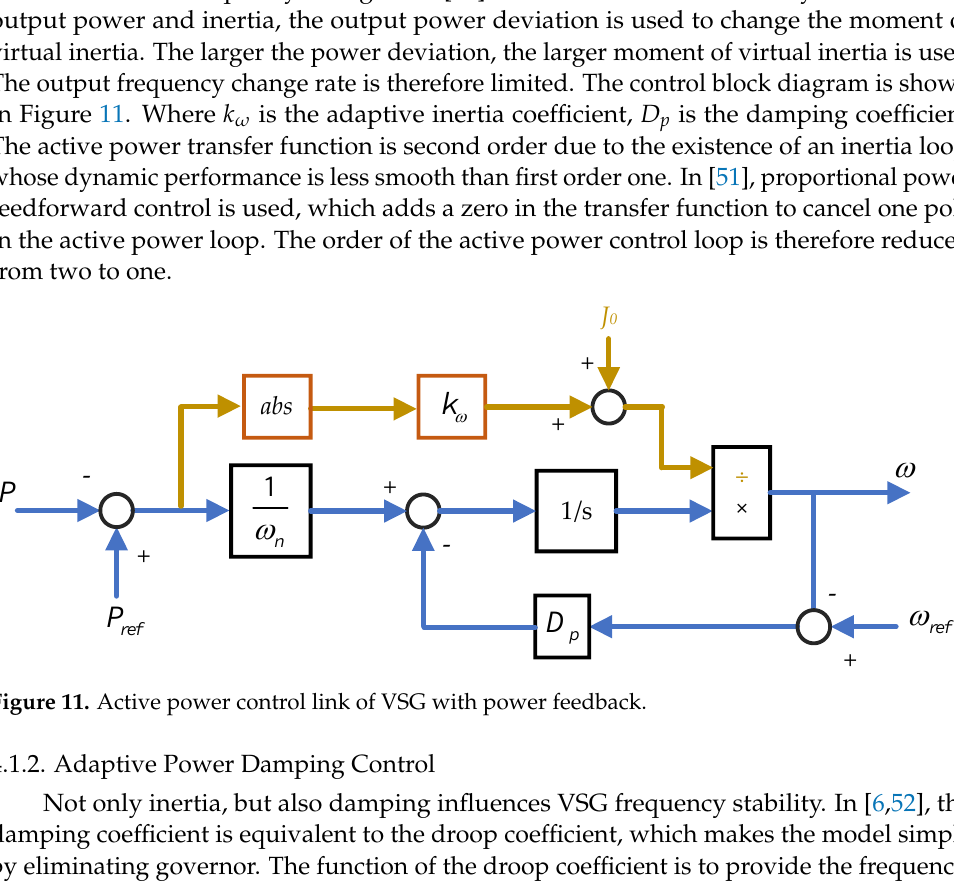
Figure 10 . ( a ) feedback modes of the power-angle control of the VSG; ( b ) Block diagram of mode-